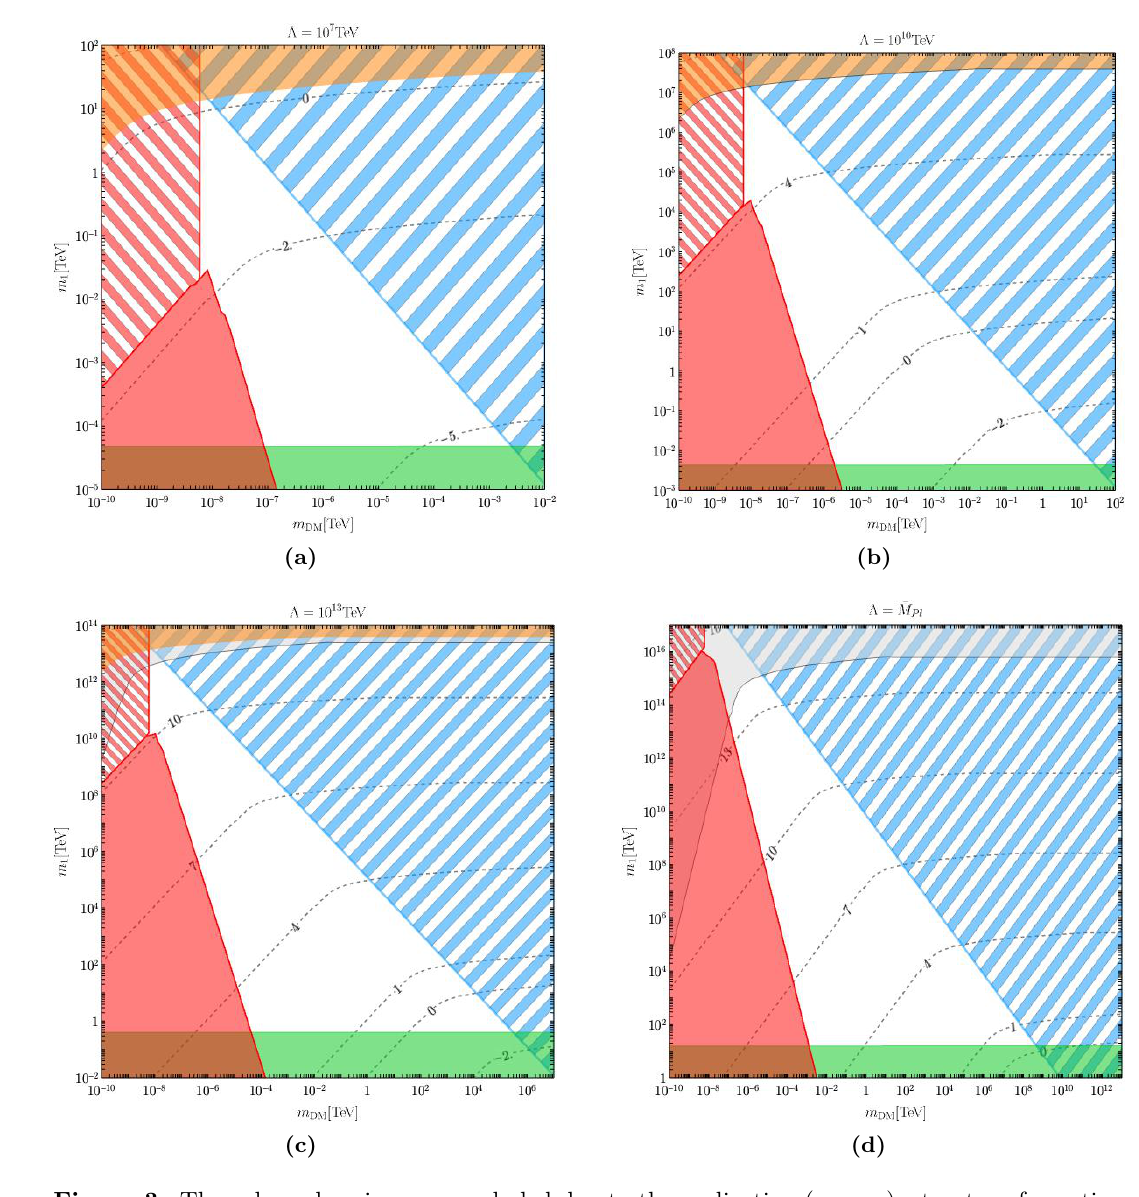
Figure 3. The coloured regions are excluded due to thermalization (orange), structure formation (red), BBN (green) and unitarity (gray). The low-reliability region of the yield and structure formation is shown in light-blue and with a meshed shading, respectively. The dashed black lines correspond to contours with constant log T r 10